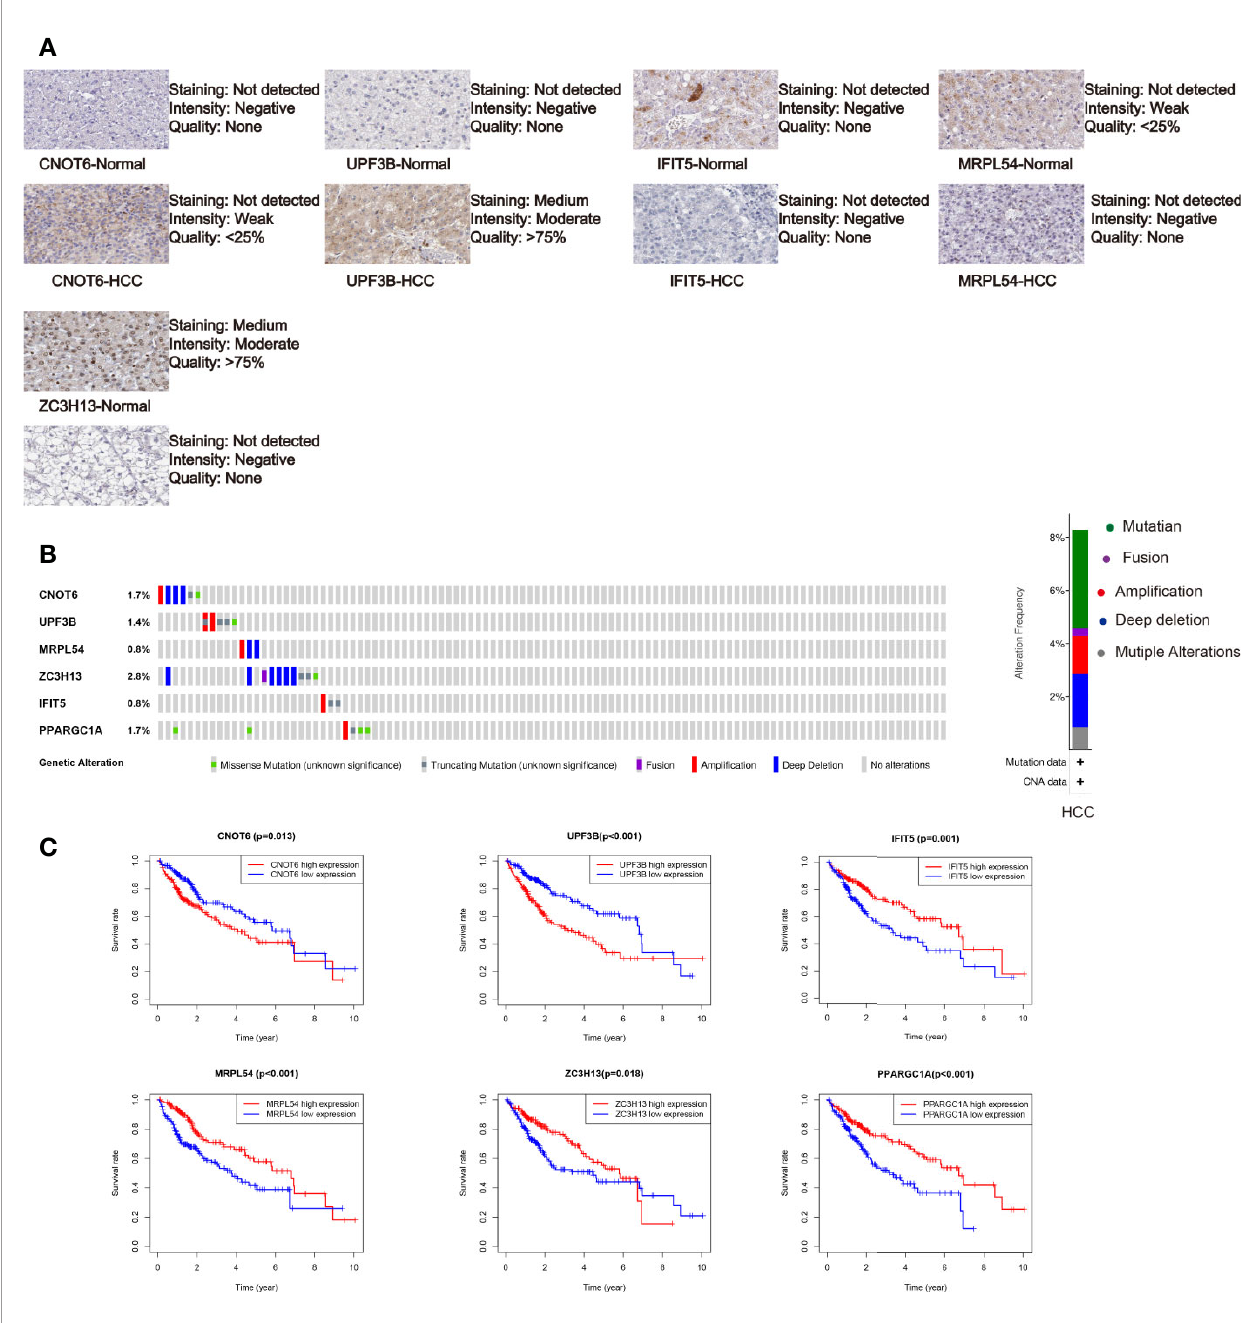
FIGURE 5 | Comprehensive analysis of the six selected RBPs (CNOT6, UPF3B, MRPL54, ZC3H13, IFIT5, and PPARGC1A). (A) Immunohistochemistry of fi ve RBPs using HPA database, except PPARGC1A. (B) Alteration analysis of these RBP genes. (C) Kaplan-Meier survival curves for the six